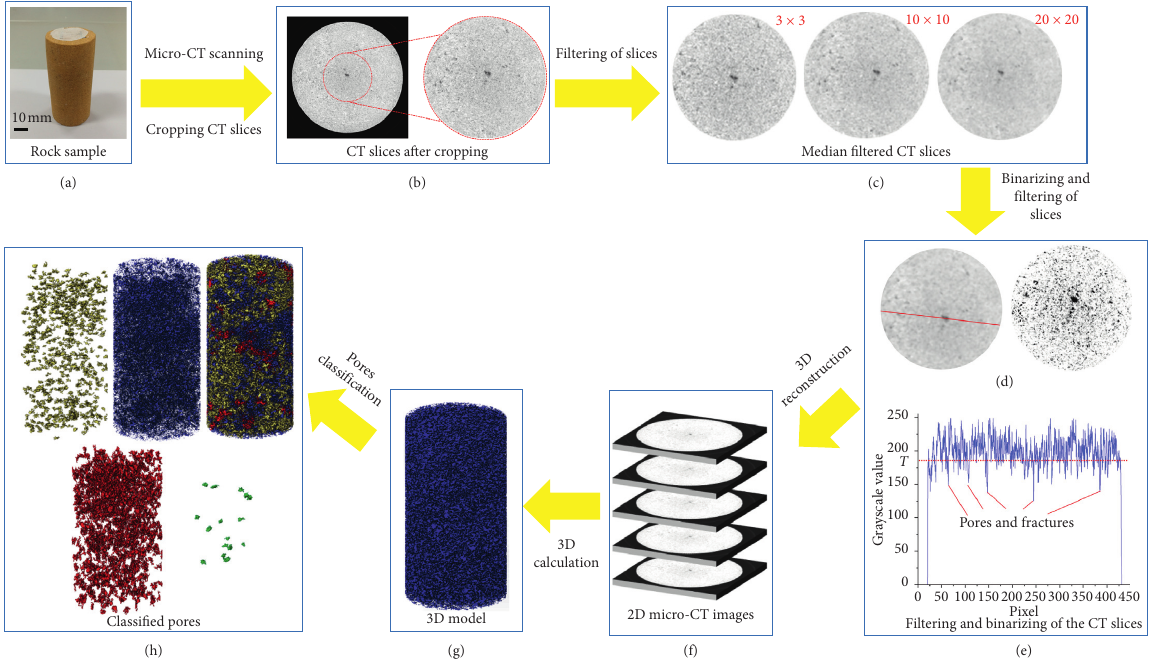
Figure 4: (a) Rock sample. (b) CT slices after cropping. (c) Median-filtered CT slices. (d) Binarized images of CT slices. (e) Variations in grayscale values along a scan line. (f) 2D micro-CT images. (g) 3D model. (h) Pore classification and